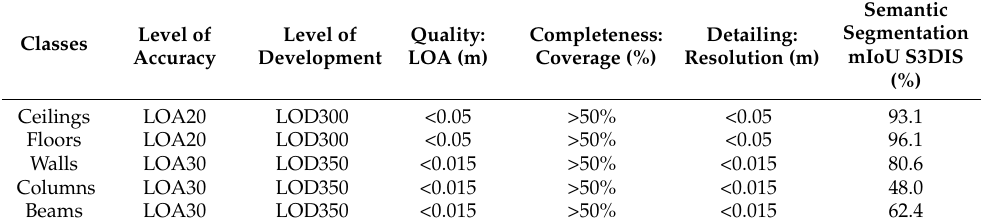
Table 2. Overview of the BIM modeling/evaluation requirements for structure classes as reported by Wang et al. [4] and Rebolj et al. [42]. The IoU percentual values are directly obtained from Hu et al.